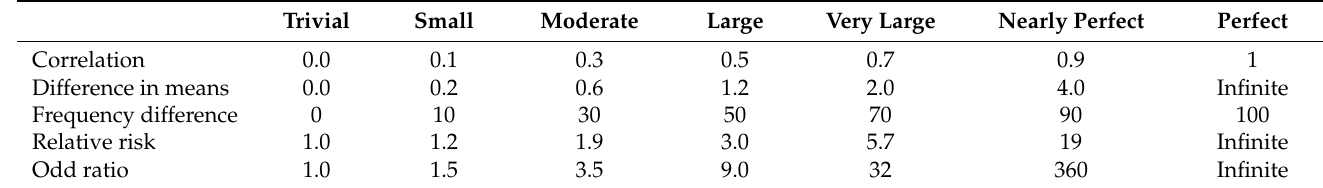
Table A2. Cohen’s Table of Effect Size.